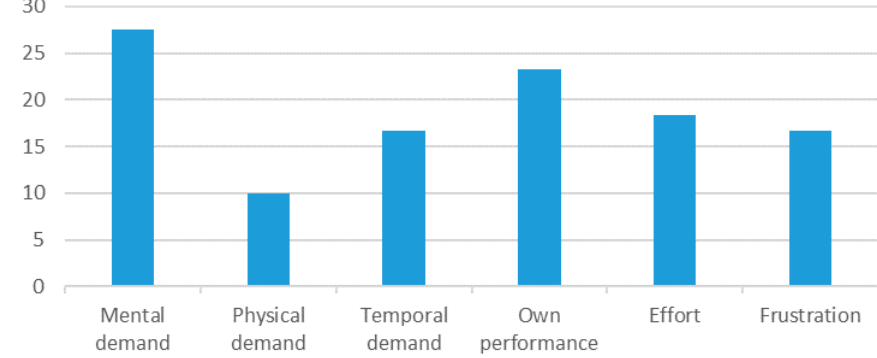
Figure A3. Preliminary prototype application user testing: NASA-Task Load Index results.